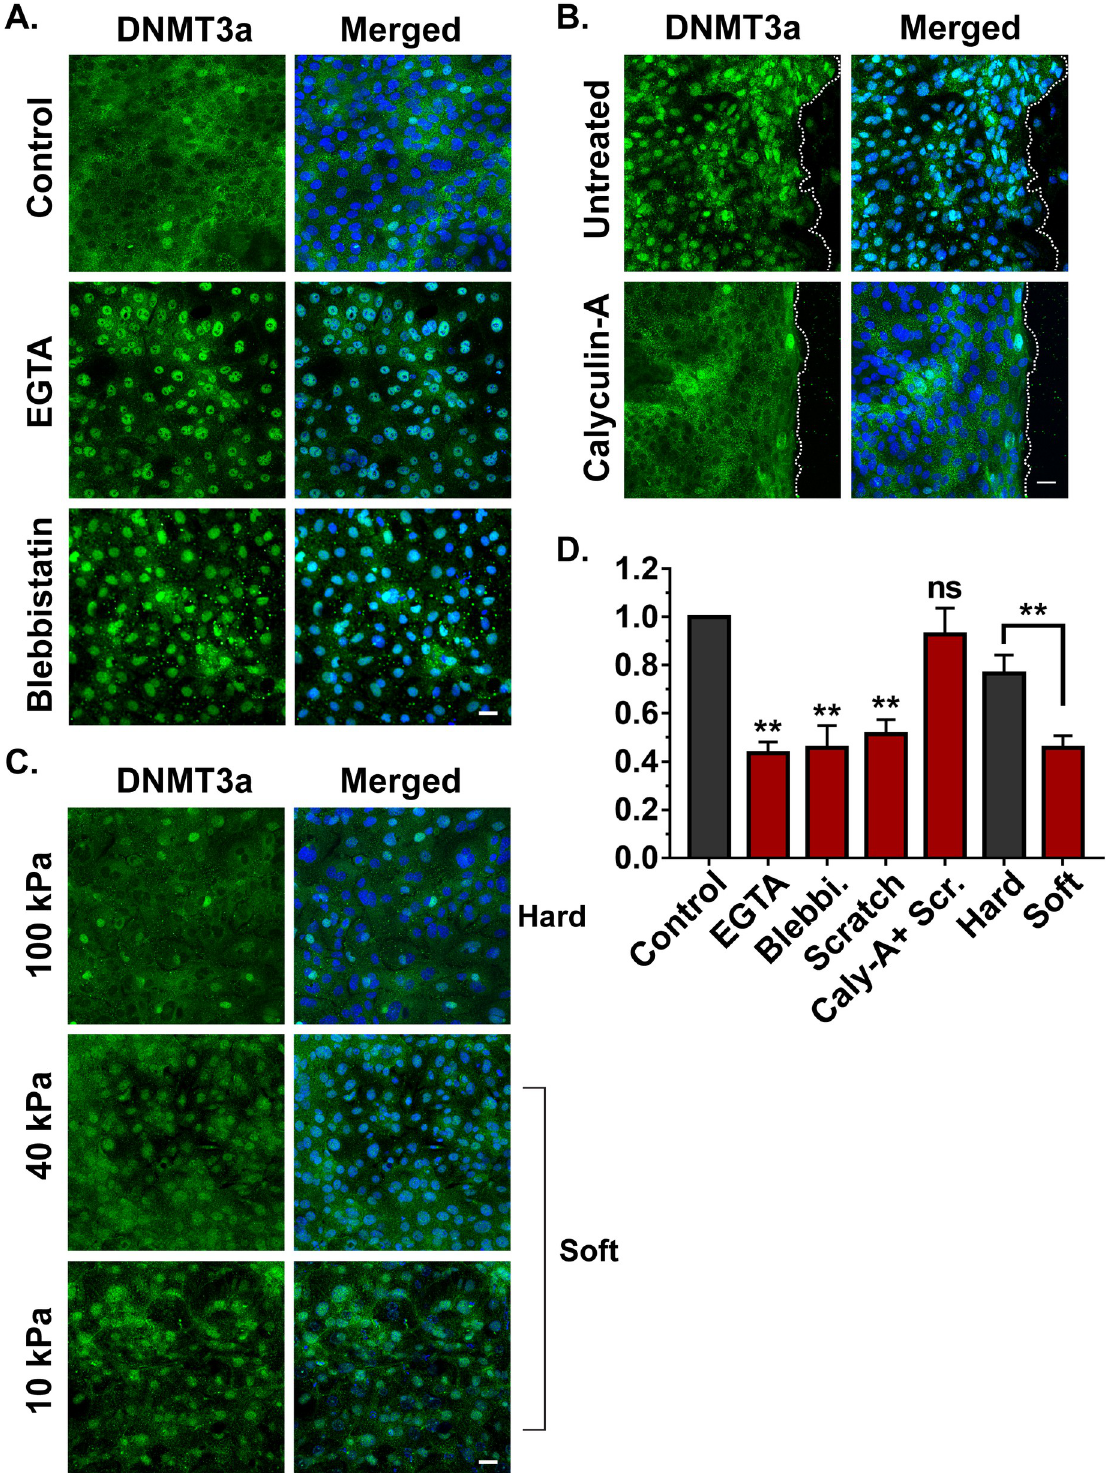
Fig 4. Effect of cellular tension on DNMT3a localization and caspase-8 expression. ( A ) Effect of EGTA and blebbistatin on the localization of DNMT3a. ( B ) Effect of scratch wound DNMT3a localization in presence and absence of calyculin-A. ( C ) Effect of various matrix stiffness on the localization of DNMT3a. ( D ) Fold change in the levels of caspase-8 mRNA as a result of varios pharmacological and mechanical approaches of tension modulation ( n = 4), [scale bar = 20 μ m]. (Data are shown as mean ± SEM, P -values were calculated